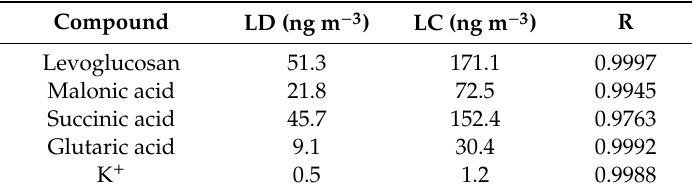
Table 4. Limits of detection and quantification of the method, and correlation coe ffi cient for each of the detected compounds.